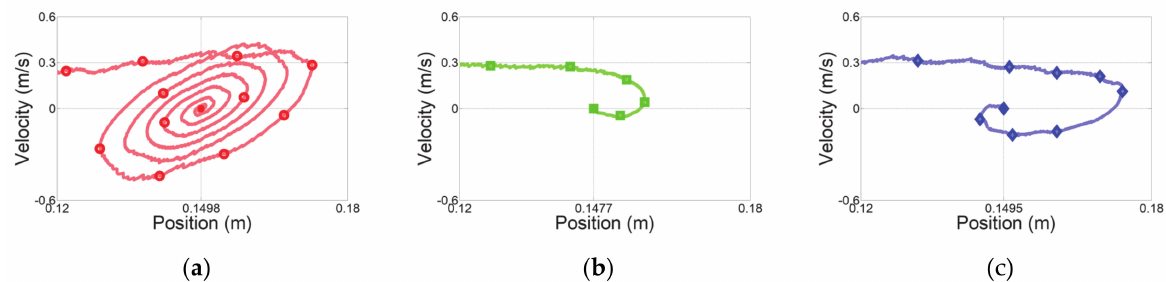
Figure 10. Position–velocity graphs along the x axis for experiment with sudden change in operator’s intention. Admittance control with ( a ) low and ( b ) high admittance parameters and ( c ) proposed variable admittance control based on